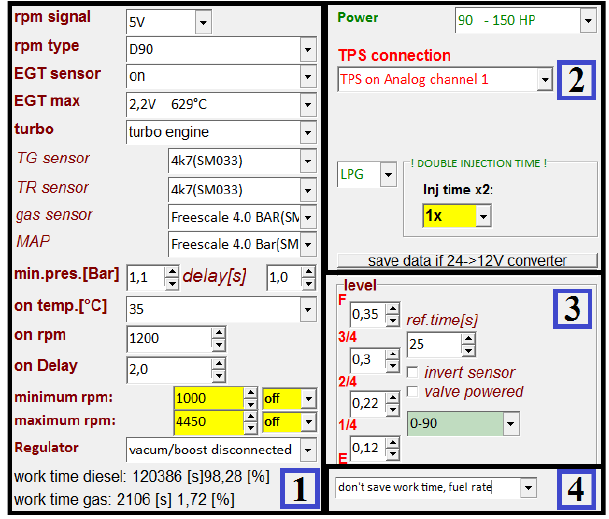
Fig. 6. DF ECU basic configuration screen [14]: 1 – main parameters, 2 – additional parameters, 3 – level sensor settings, 4 – save